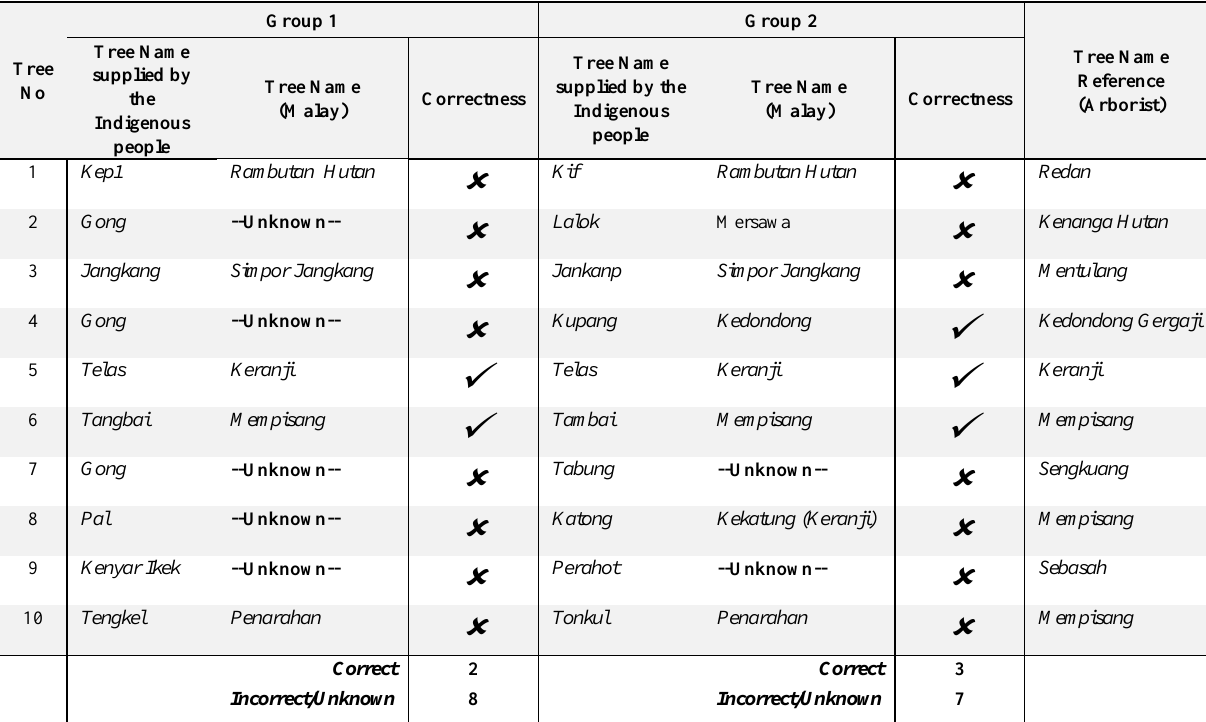
Table 8. Tree names provided by groups in task 3 and the reference